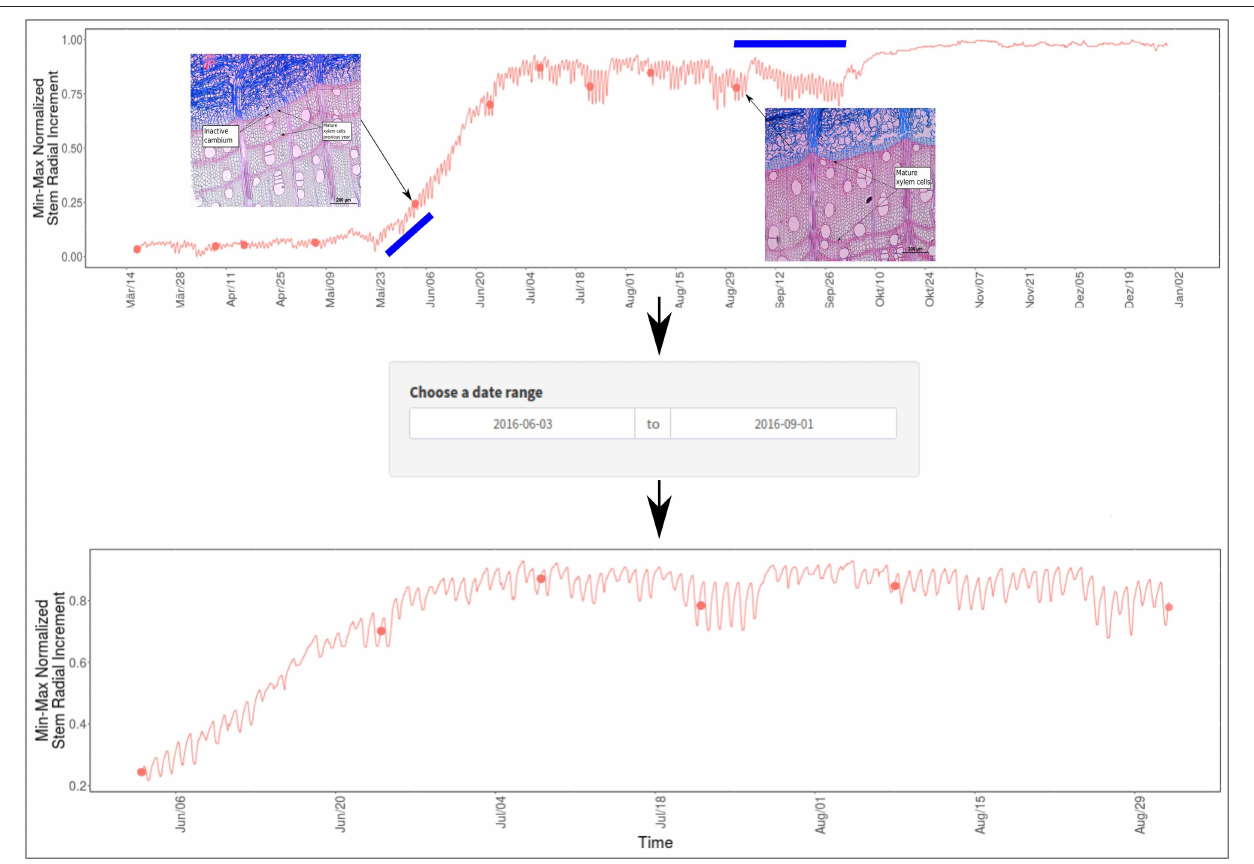
FIGURE 5 | DevX image composition displaying how to find the period of active growth in dendrometer series. In the top diagram, the identified microcore images indicate that the period in between contains the active growth signal in the dendrometer curve. The periods marked with a blue bar, when considering the xylogenesis stage at that point in time, can be attributed to signals regarding other factors affecting stem